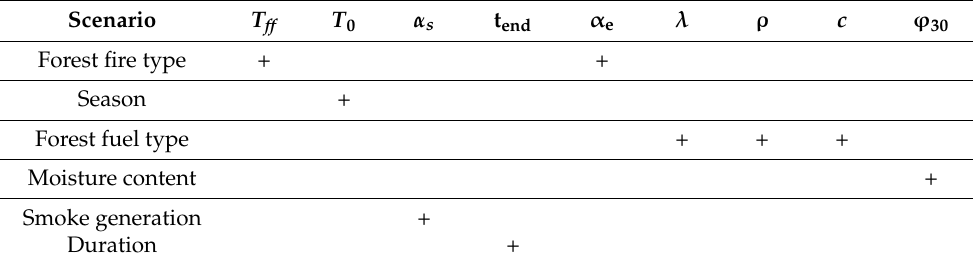
Table 1. Correspondence of scenarios and various parameters of the model. Scenario T